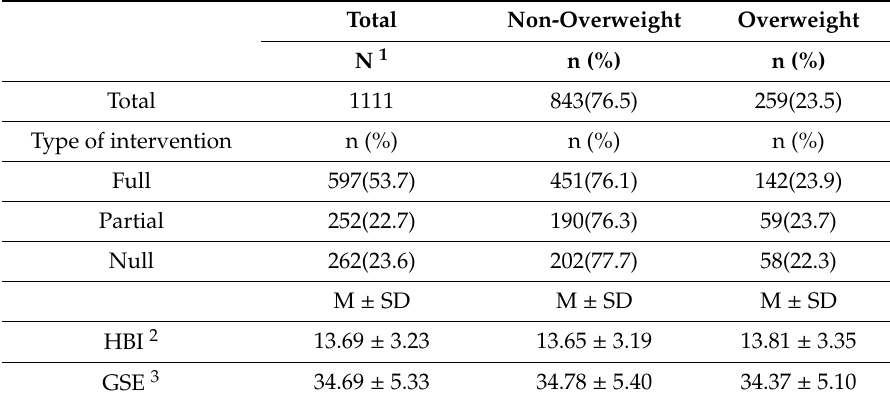
Table 2. Sample characteristics at the